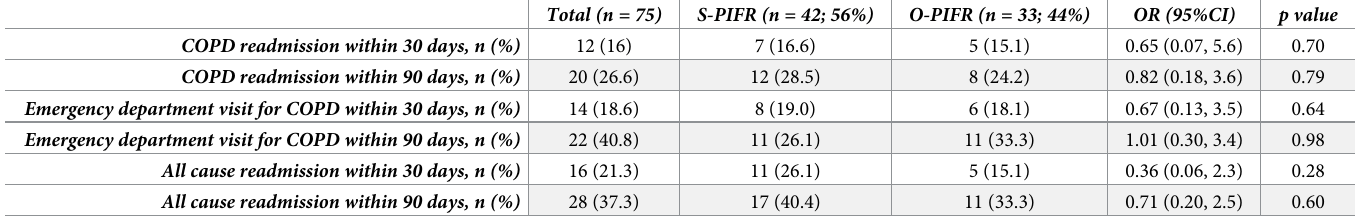
Table 2. Readmission rates for all patients, suboptimal PIFR (S-PIFR) and optimal PIFR (O-PIFR). CI: confidence interval; COPD: chronic obstructive pulmonary disease; OR: Odds Ratio, P values: S-PIFR vs